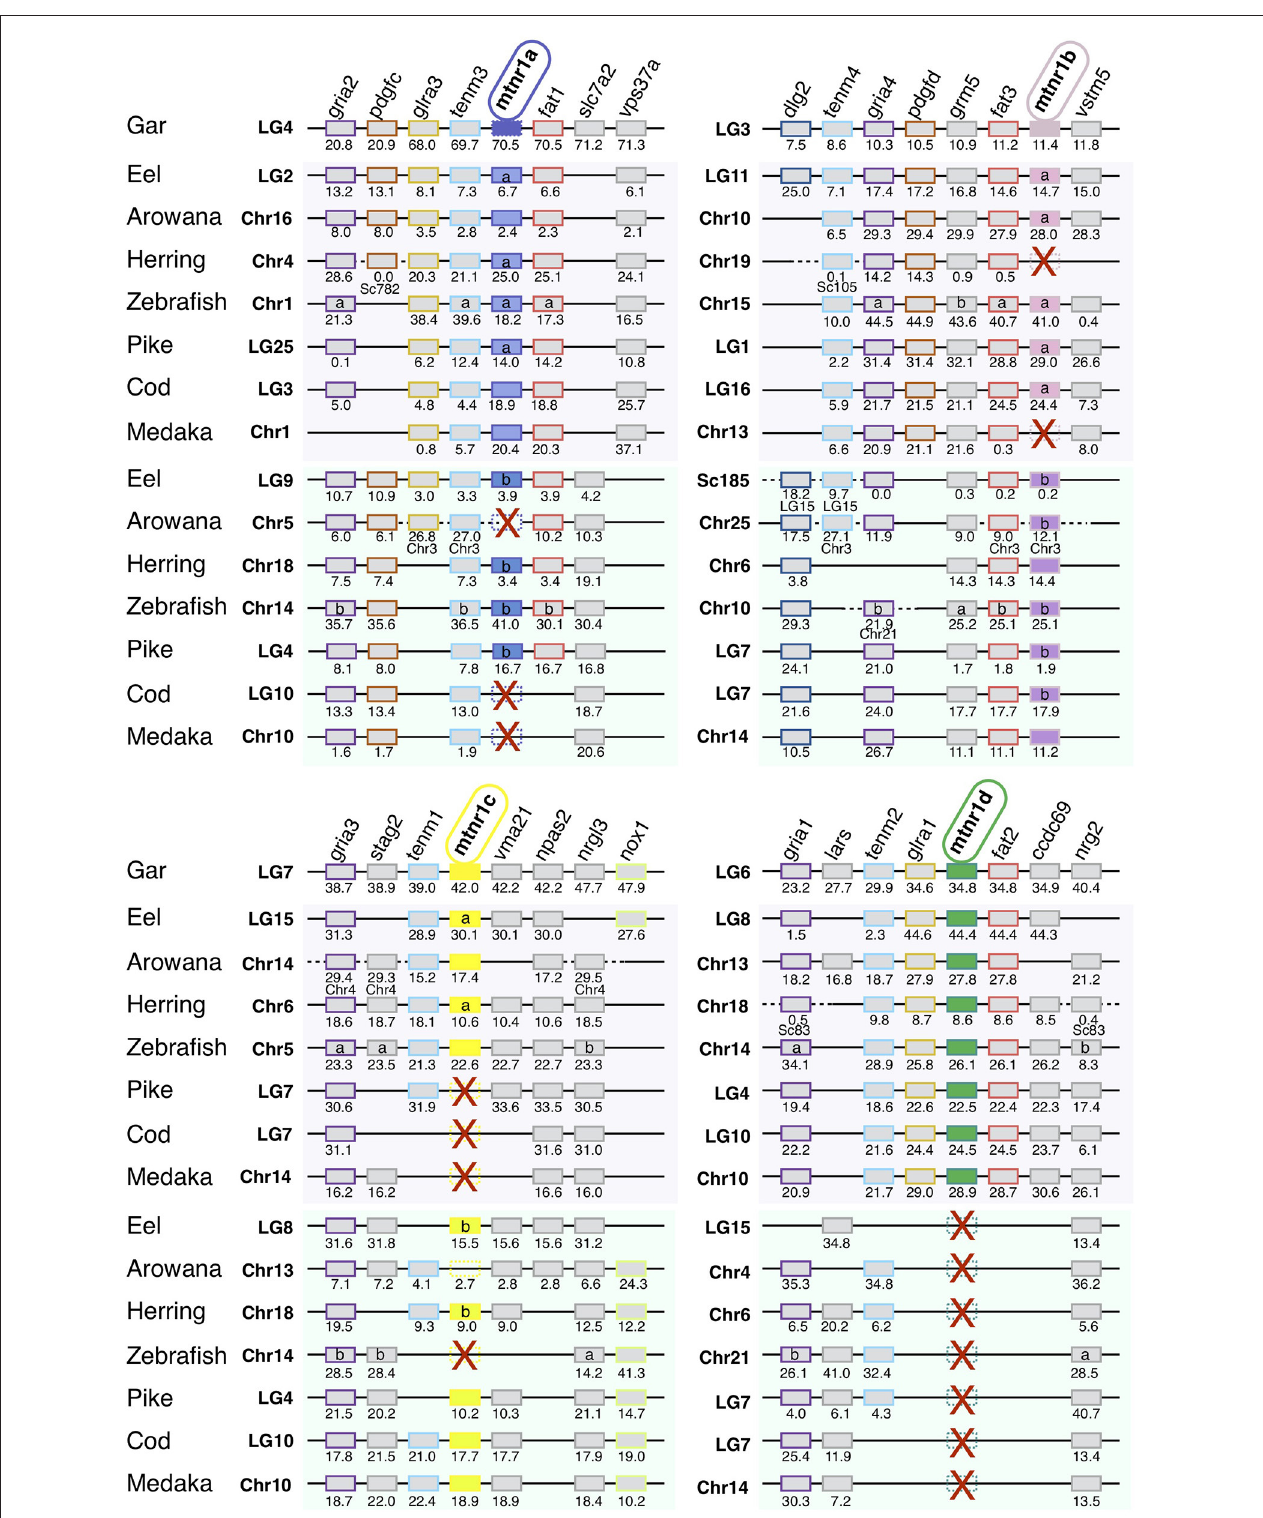
FIGURE 4 | Conserved syntenic region of melatonin receptors in actinopterygians. Locations are given in Mb. Gene order follows that of the spotted gar chromosomes LG4, LG3, LG7, and LG6. Each neighboring gene family is displayed with a specific color. Red crosses indicate mtnr gene loss. In the spotted gar, the mtnr1a was found as pseudogene, in the genome assembly but a transcript encoding a functional receptor was found in the PhyloFish database. We assumed that the mtnr1a pseudogene form results from an assembly error, and therefore the mtnr1a is represented by the mtnr1a blue box, but with the edges dotted. The new